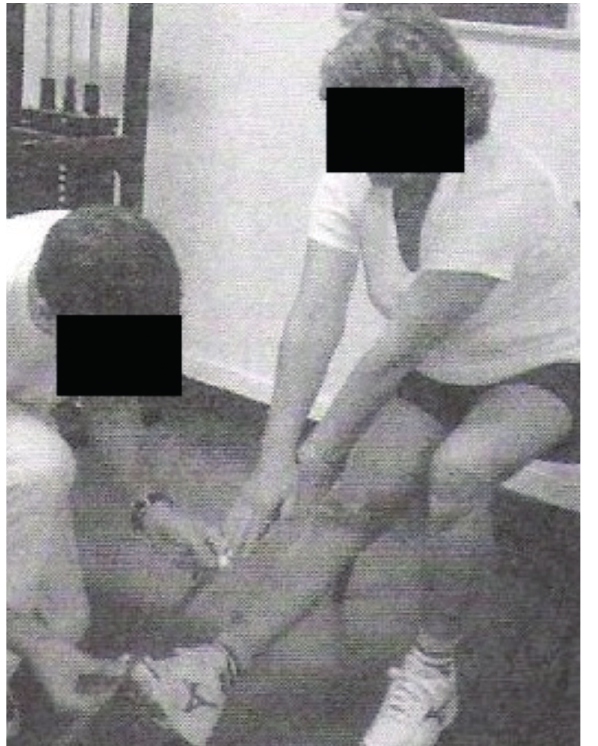
Figure 2 - Reach behind the back Source: Rikli and Jones